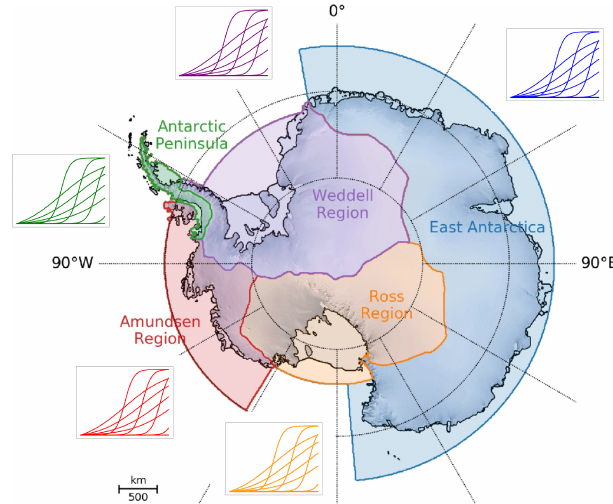
Figure 4. LARMIP regions to which basal melt rate anomalies were applied, adapted from Levermann et al. (2020). Each basin pulls random sigmoid shapes for each ensemble member, with the max- imum value at the final year (200) scaled to a basin-specific value, illustrated by the schematized color-coded melt rate